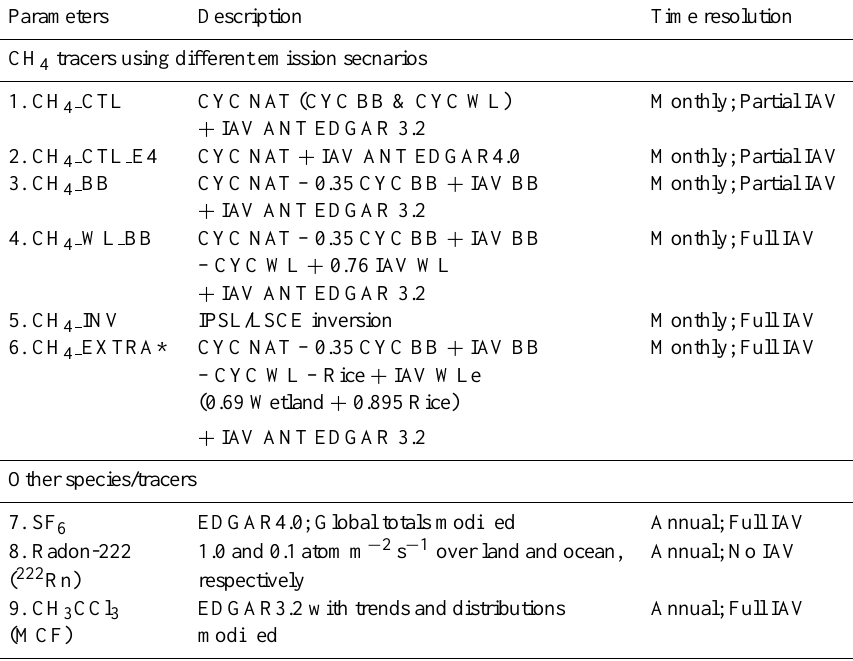
Table 1. List of tracers simulated in the TransCom-CH 4 intercomparison project. See Sect. 2.2 for a description of the CH 4 flux